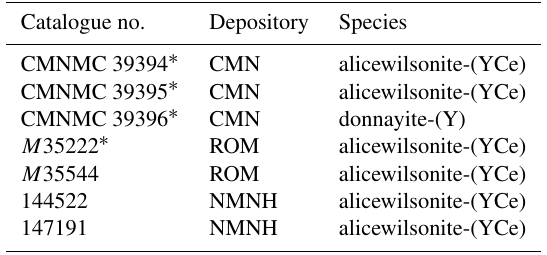
Table 1. Results of re-investigation of donnayite-(Y) cotypes.